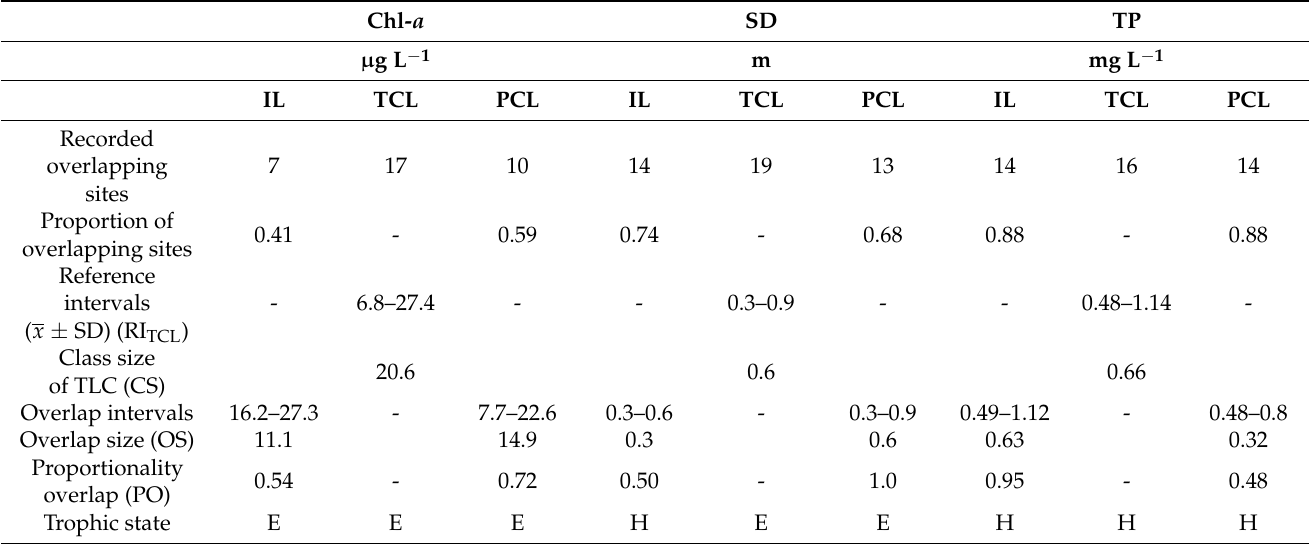
Table 1. Proportionality overlap of indicator data distribution between TCL with IL and PCL and trophic state in three conditions of surface hydraulic connection. mean = x ; standard deviation = SD.